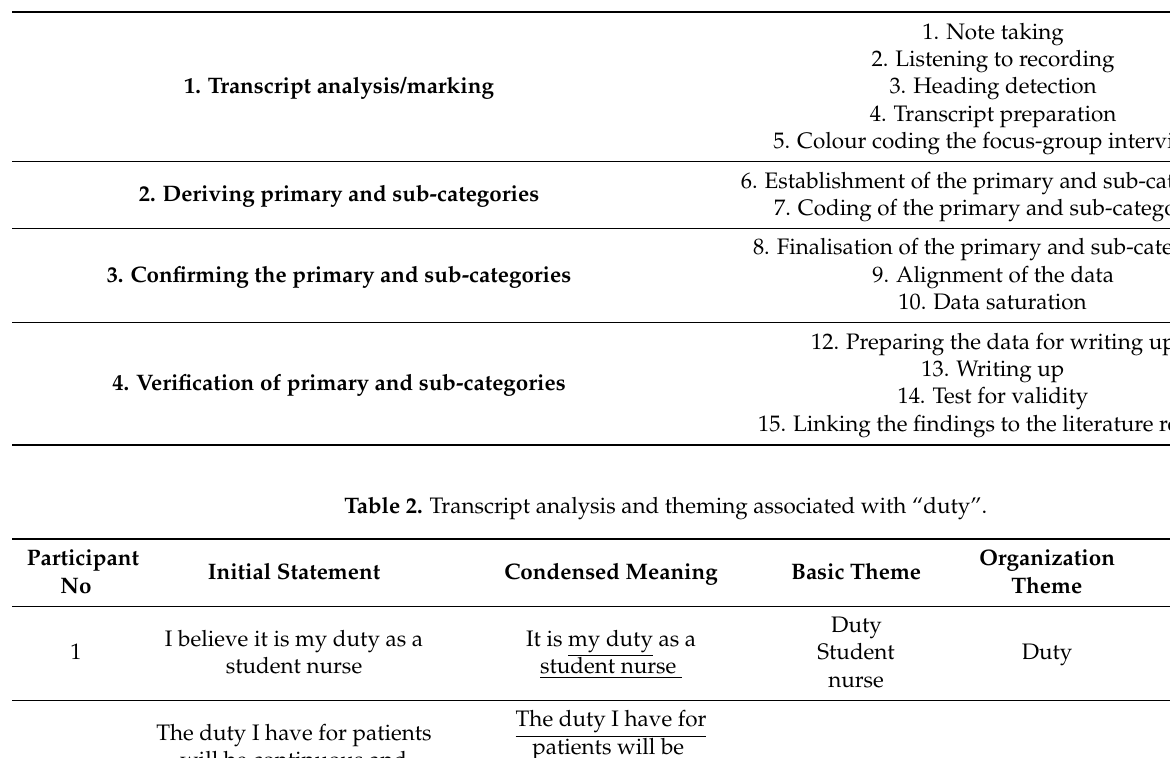
Table 1. Phase Burnard’s stages to emulate the student experience.